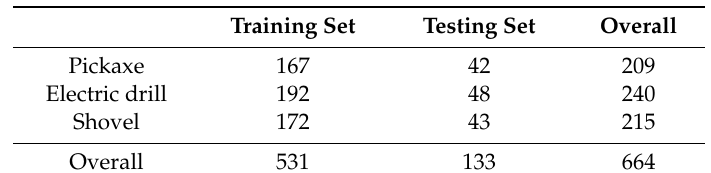
Table 1. Samples of training set and testing set